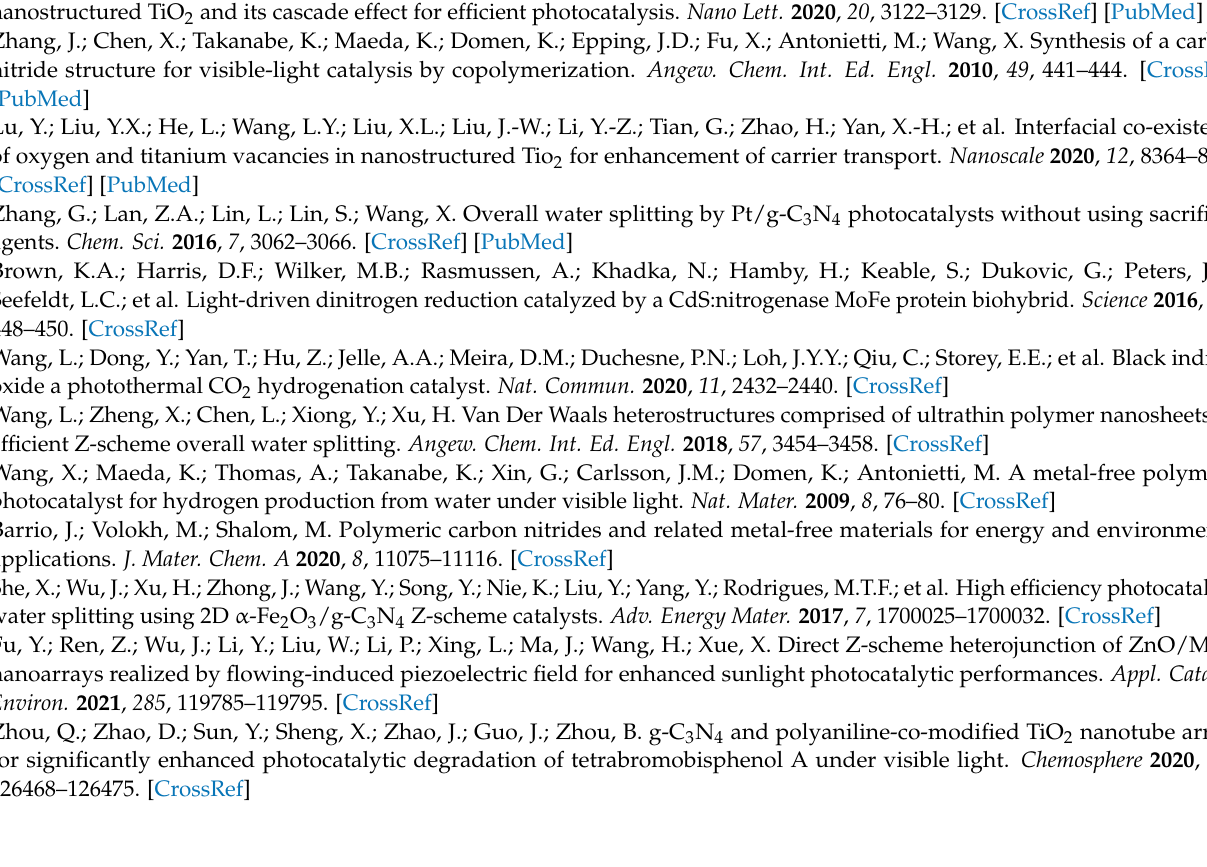
heterojunction film; Figure S2: Photocatalytic H 2 evolution rate of the CN/PANI heterojunction powder; Figure S3: Tauc plot of pristine CN. Figure S4: Mott–Schottky plot of pristine CN; Table S1: Comparison in photocatalytic H2 evolution activities of similar CN based